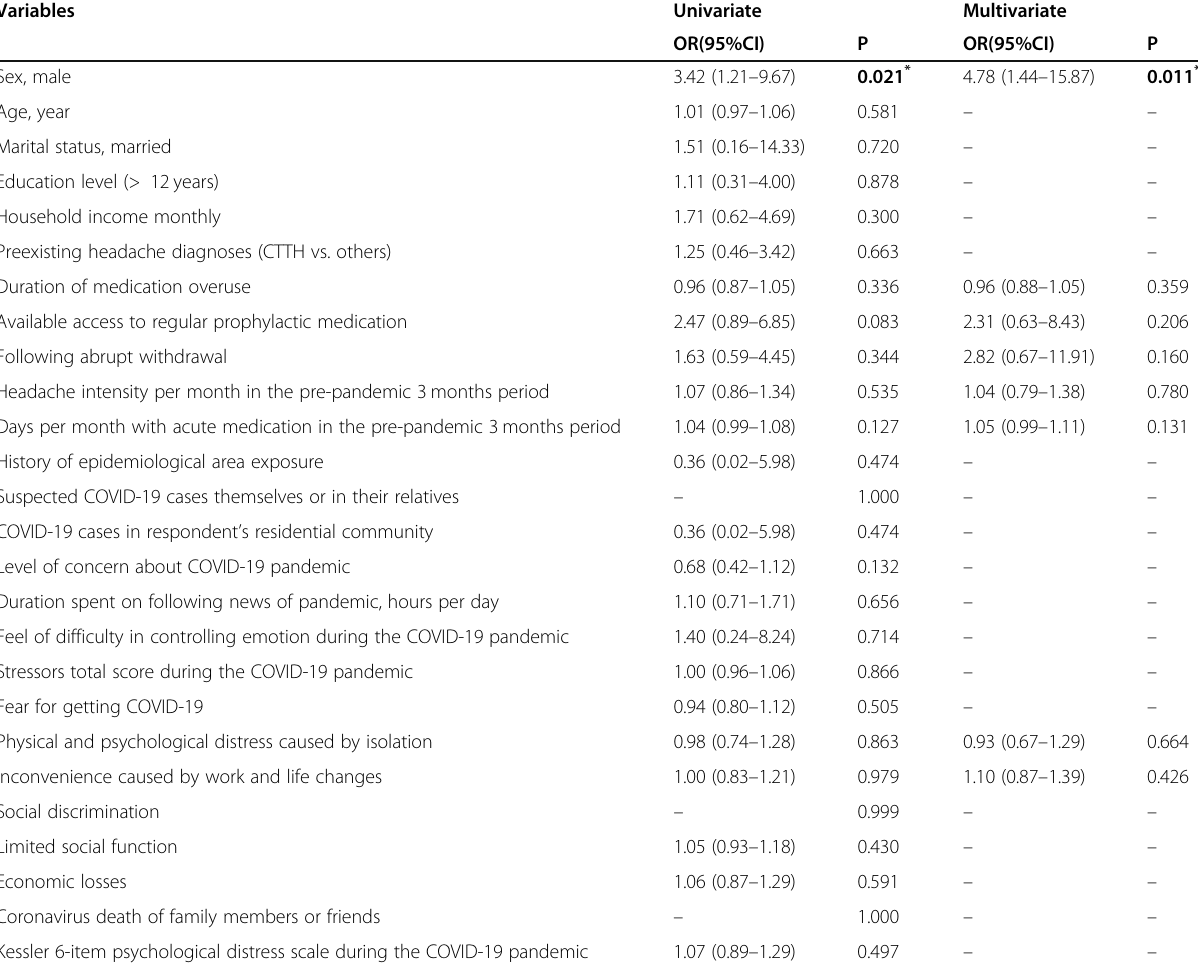
Table 5 Univariate and multivariate logistic analysis to identify independent variables decreasing days with acute medication